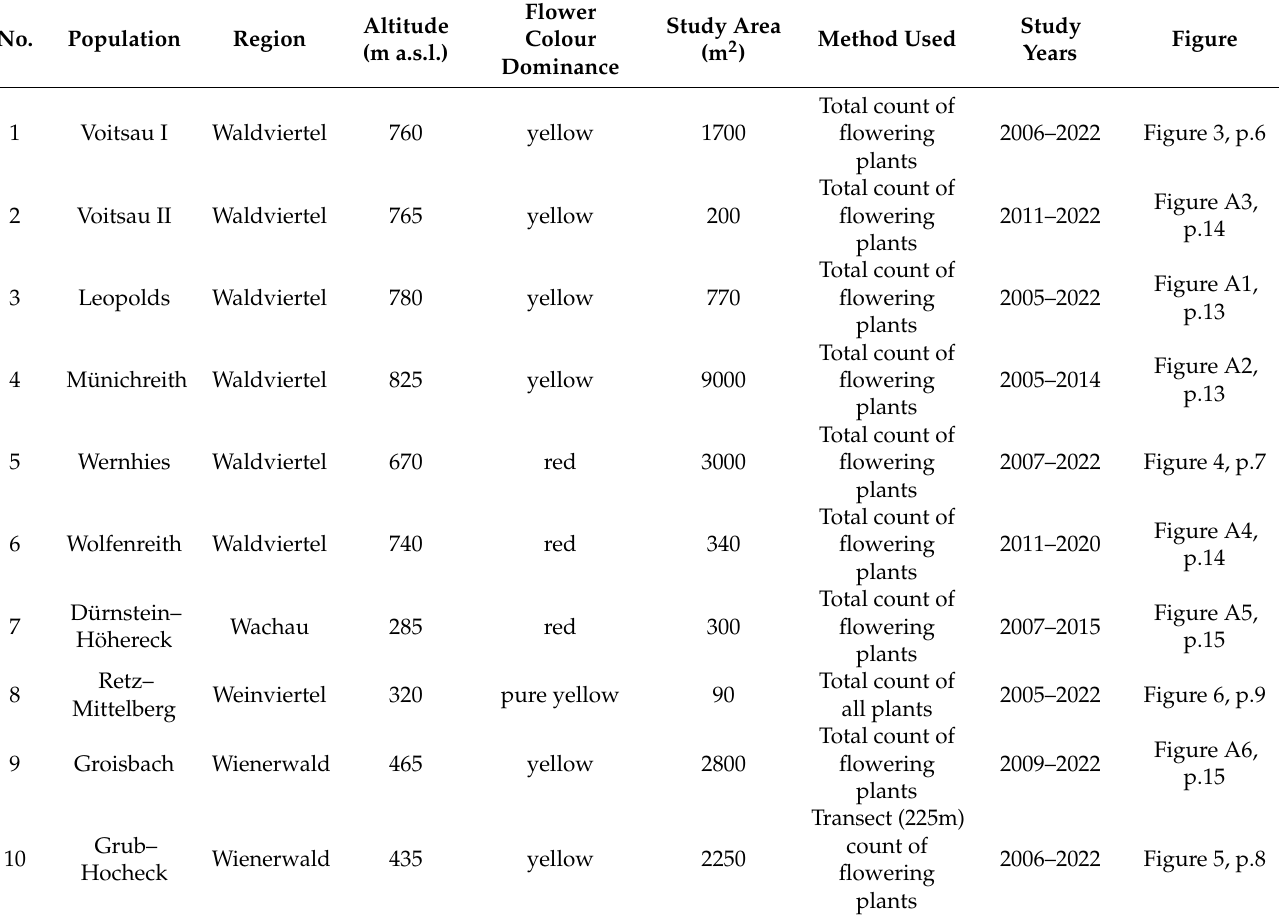
Table 1. Overview of Dactylorhiza sambucina populations with differing flower colour dominance studied, providing information about the region, the study area and years, and the different meth- ods